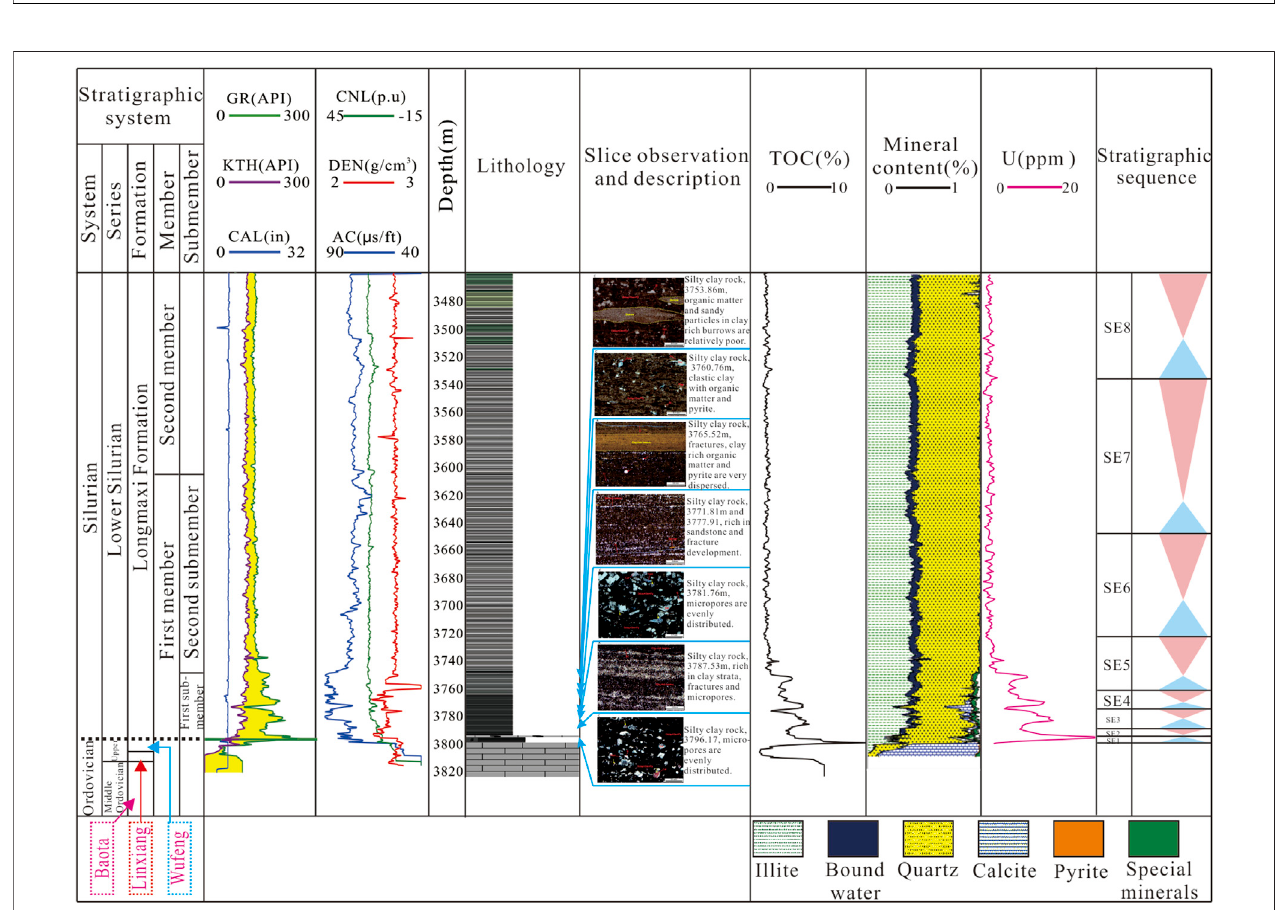
FIGURE 2 | Comprehensive histogram of the Longmaxi Formation of well W206.